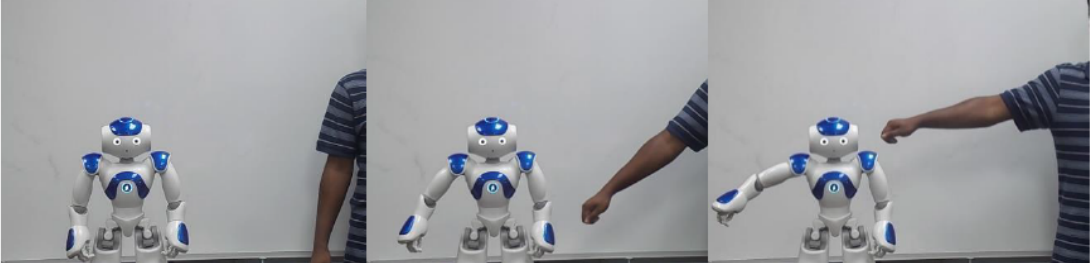
Figure 9: Arm position of the human operator and NAO robot during shoulder joint abduction/adduction